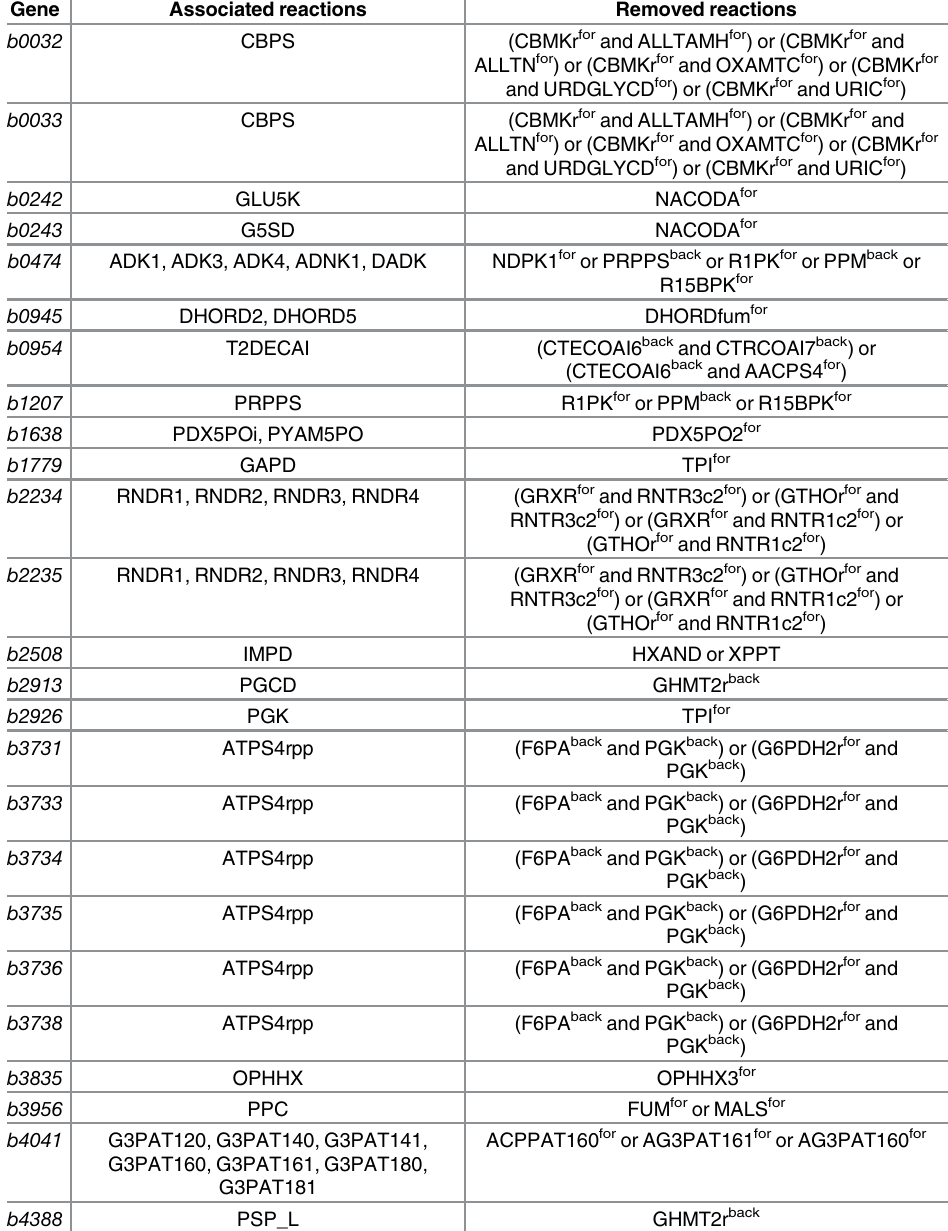
Table 8. Removal of reactions of the E . coli network suggested by GlobalFit to correct FPp. Gene Associated reactions Removed reactions